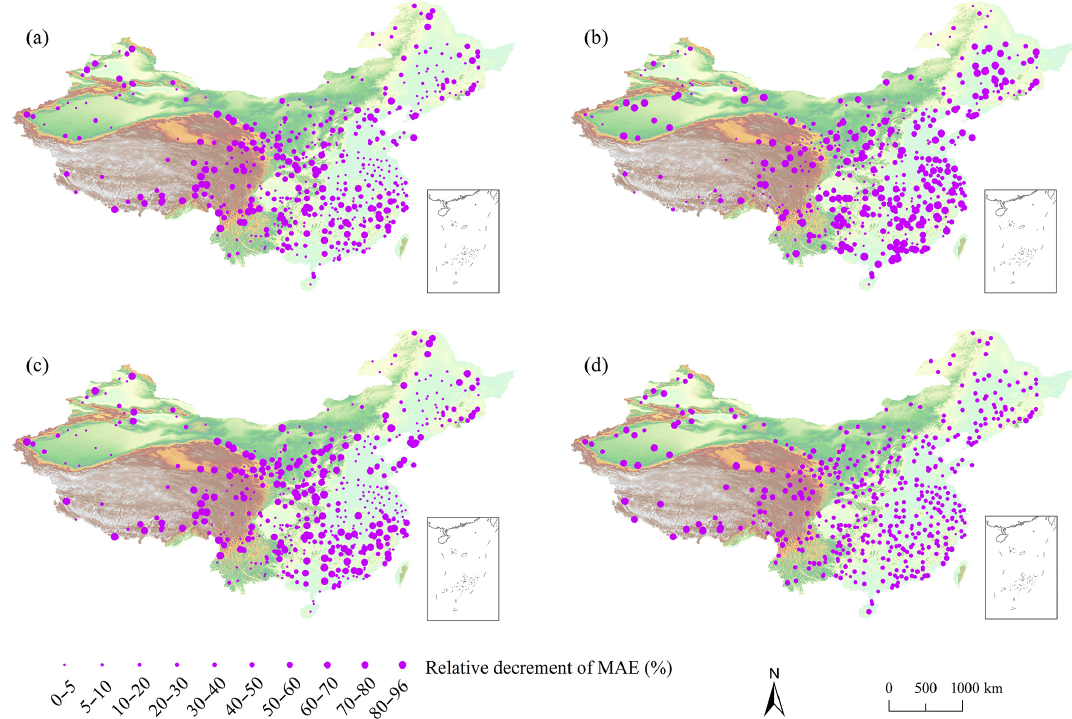
Figure 5. Relative decrement in MAEs from the 30 (cid:48) original datasets to 0.5 (cid:48) downscaled datasets generated using bilinear interpolation at each independent weather station. Panels (a) – (d) are the relative decrements in MAE for the monthly minimum, mean, and maximum temperatures as well as monthly precipitation,